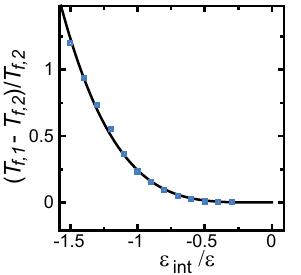
T f ,2 )/ T f ,2 . Filled squares: PWFRG (DMRG) calculated points. Solid line: − ( T f ,1 T f ,2 )/ T f ,2 , x = −